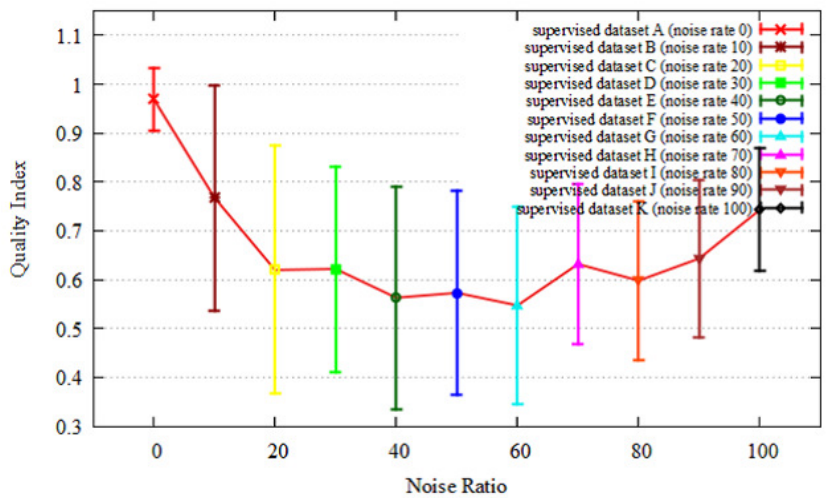
Figure 13. Quality index of each dataset in scenario 2.